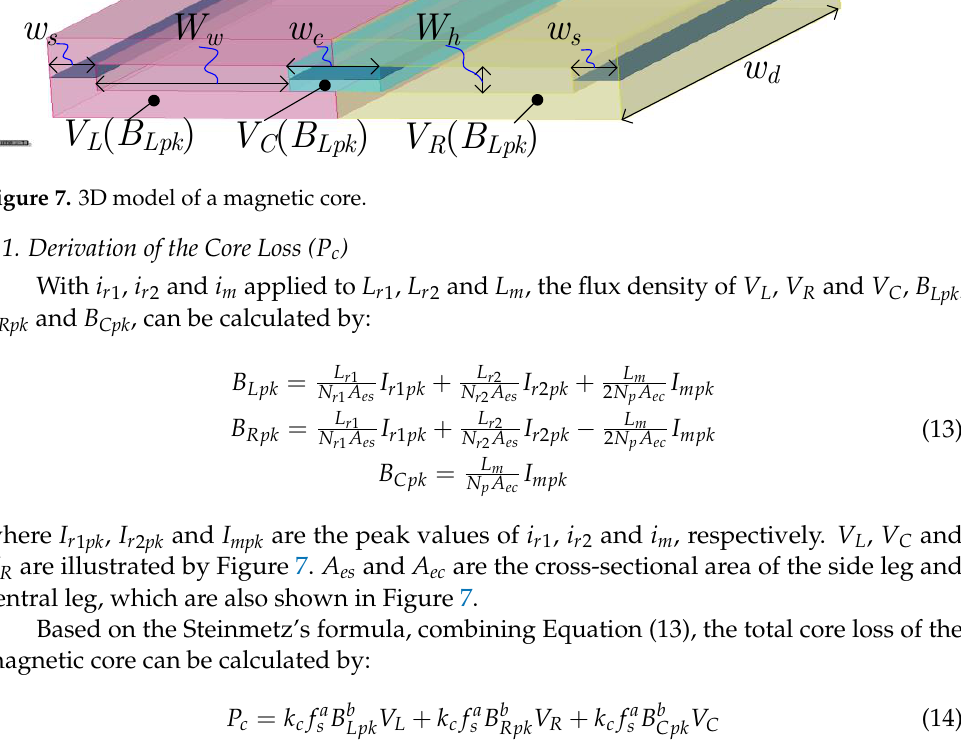
Table 2. The Sizes of the magnetic